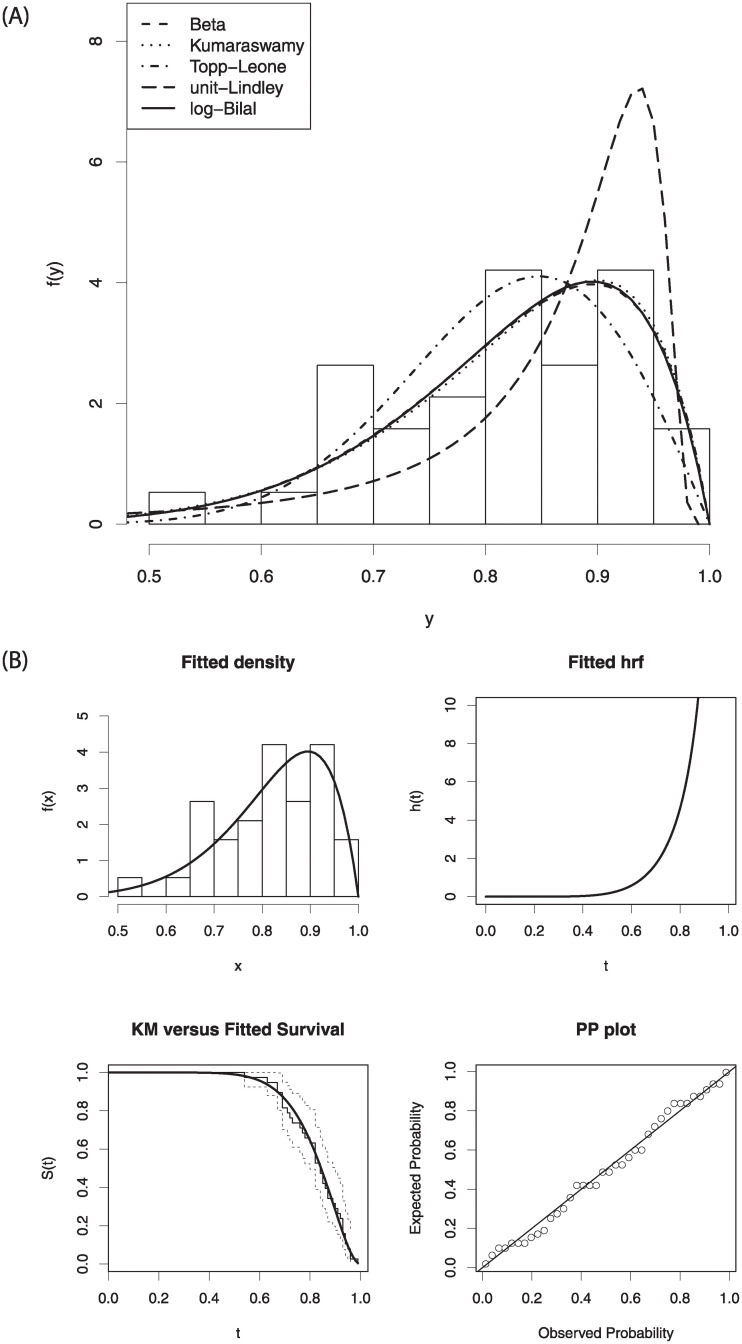
The estimated pdfs of the fitted distribution (left-panel) and some fitted functions of the log-Bilal distribution (right-panel).